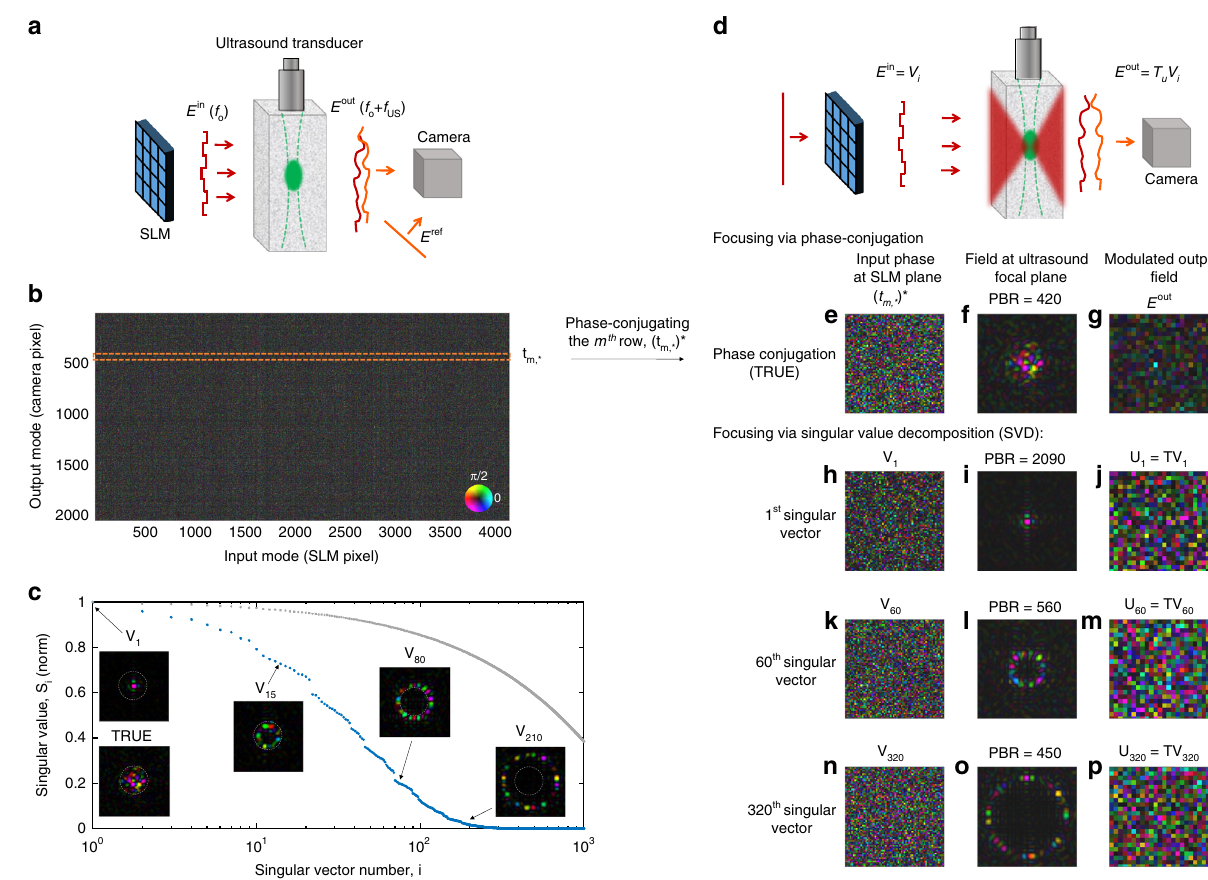
Fig. 1 Acousto-optic transmission-matrix simulated acquisition and use. a Considered setup for acquiring the acousto-optic transmission matrix (AOTM): ð Þ at the laser frequency f The AOTM is acquired by injecting a basis of optical modes E in n f o into a multiply-scattering sample using a spatial light modulator o þ f ð Þ , with a camera, using a pulsed reference beam at the ultrasound (SLM), and recording the ultrasound modulated light outside the sample, E out m f o US þ f shifted frequency E ref f o US